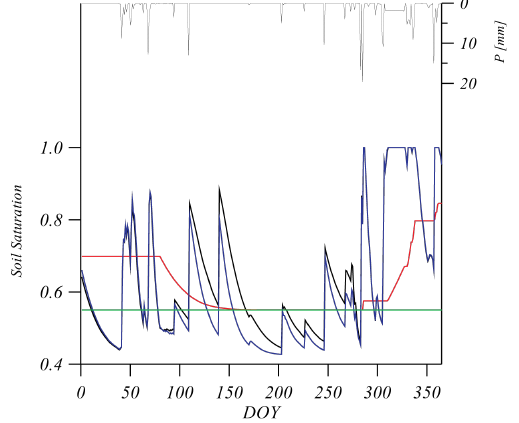
Fig. 11. Model outcome for the whole year 2010: DSL’s soil satura- tion S d and USL’s soil saturation S u versus time, for extreme values of the measured vegetation cover: CC=0 and